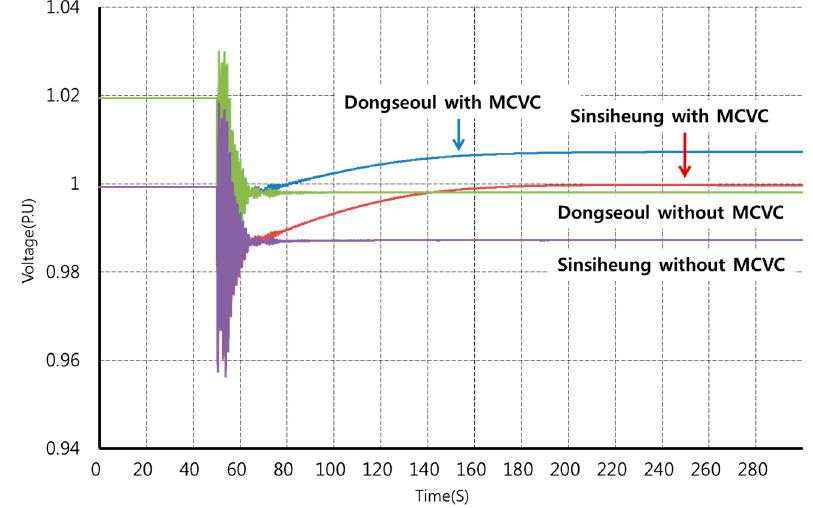
Figure 14. Result of three-phase fault at an interface line.